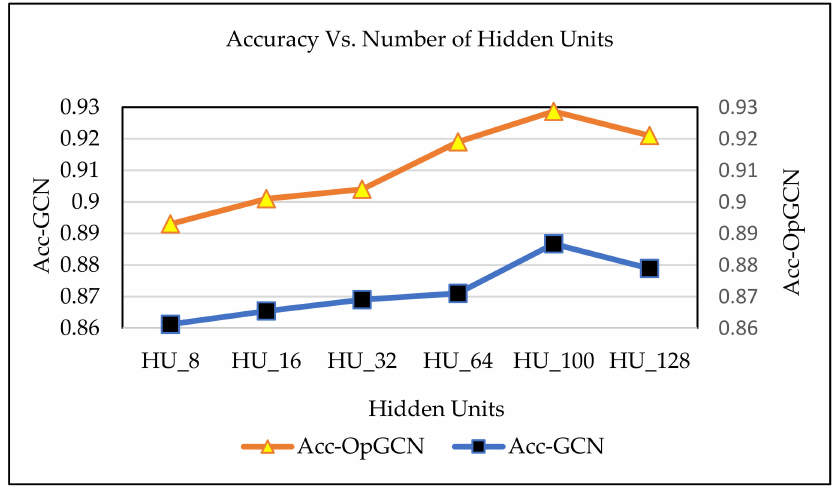
Figure 8. Accuracy (Acc) vs. Number of hidden